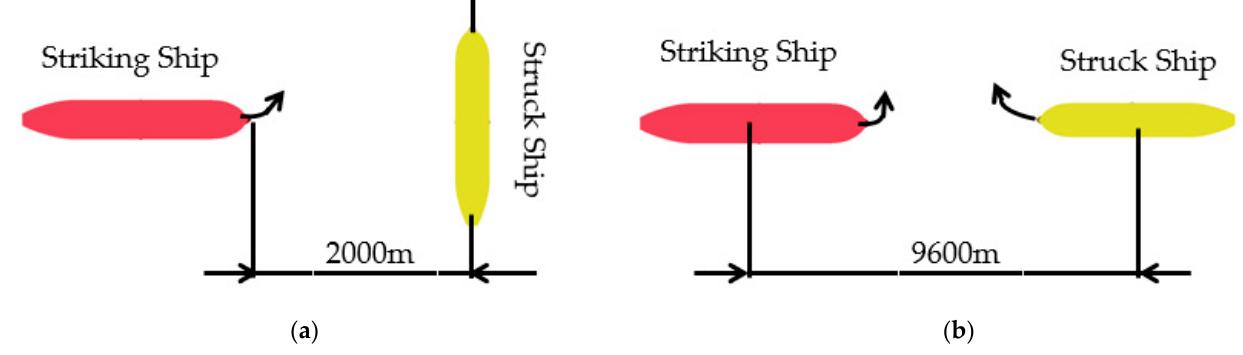
Figure 15. Scenarios: ( a ) Scenario 1—Striking Ship making a manoeuvre, ( b ) Scenario 2—Both ships making manoeuvres.